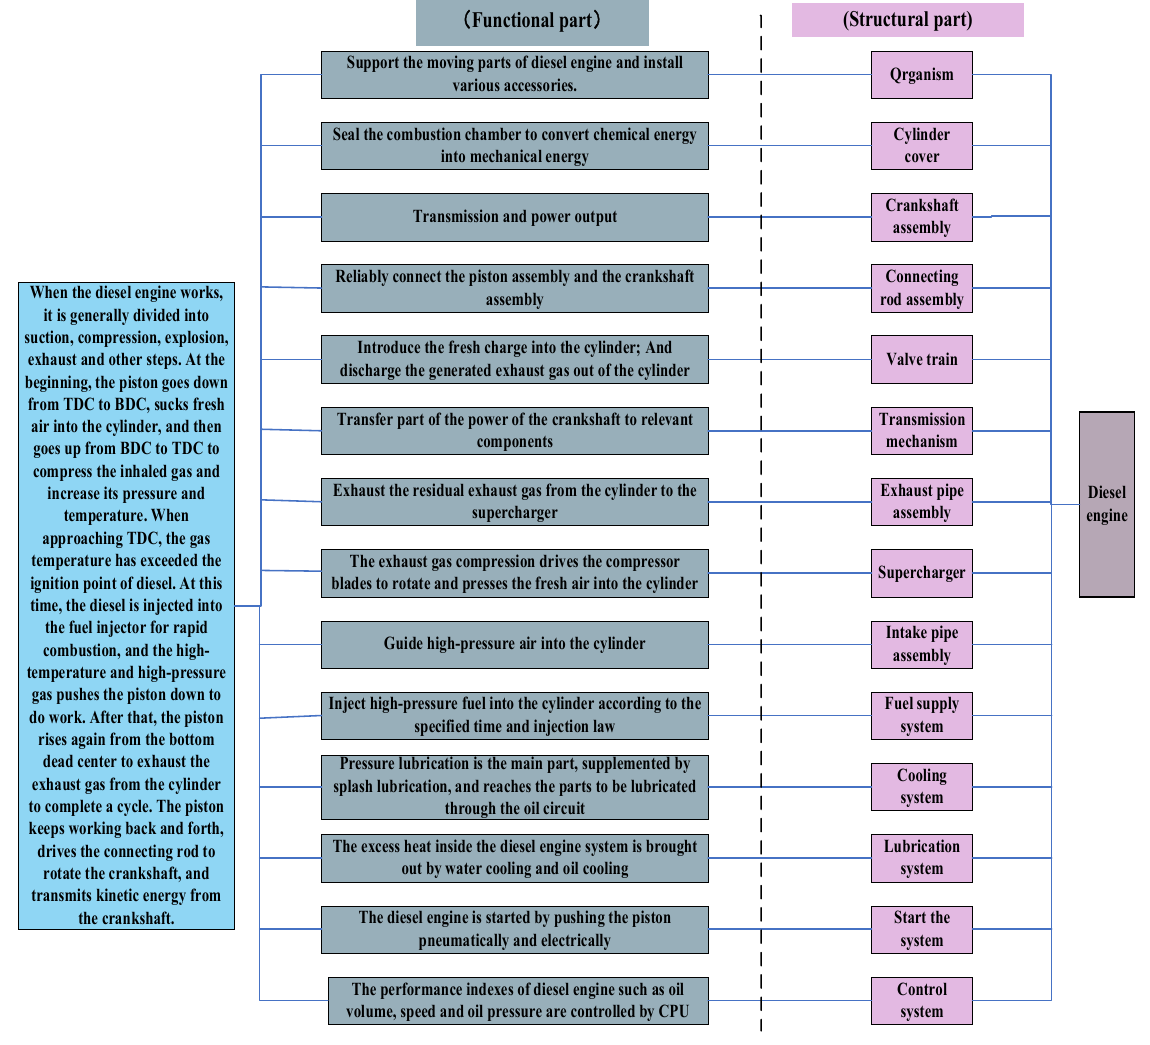
Table 7. The FMECA system-level results.